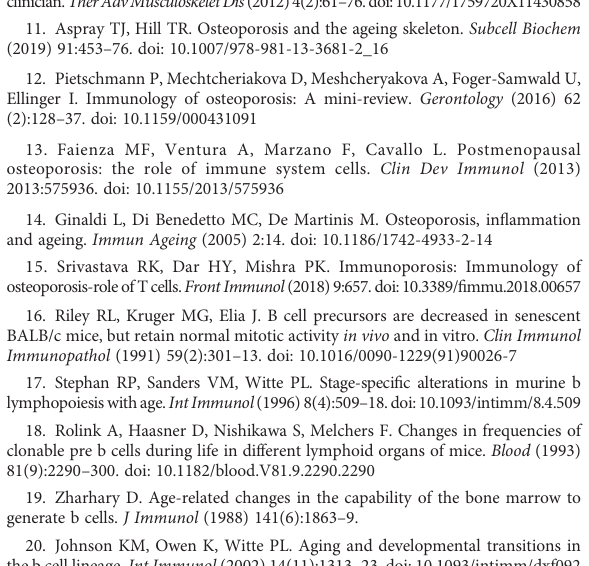
SUPPLEMENTARY FIGURE 2 Mousegenotypingandcon fi rmationoftheabsenceofpreBCRexpression in l 5 -/- mice. (A) Genotyping. The l 5 gene ( Igll1 ) was ampli fi ed by speci fi c primers. The presence of Igll1 was con fi rmed in WT and J H-/- mice (lane1 and 2, red box) while its absence was con fi rmed in l 5 -/- and J H-/- l 5 -/- mice (lanes 3 and 4). (B) Flow Cytometry. Flow cytometry was used to con fi rm the absence of preBCR expression in the mutant l 5- de fi cient strains. Early B cell subsets including preB cells were identi fi ed based on expression of surface markers including: CD19, B220, AA4.1, and BP-1. Cells were fi xed and permeabilized for intracellular staining. Antibodies speci fi c for the preBCR (SL156 clone) and Mu HC were used to con fi rm the presence of the preBCR-expressing cells in WT mice (31.1% of cells) and their absence bothon the cell surface and intracellularly in l 5 -/- mice. SUPPLEMENTARY FIGURE 3 Comparable numbers of osteoblasts and osteoclasts in bone marrow of recipientmice. (A) Undecalci fi edfemursfromadoptivetransfermicewere embedded in plastic, sectioned and stained with Masson ’ s trichrome. Representative images from the endosteal surface are shown at 10X magni fi cation. The yellow boxed region is shown at 40X magni fi cation. (B) Average histomorphometric values pooled from the indicated recipient mice (n=3-5 mice per group). No.Ob/BS=Number of osteoblasts per bone surface, ObS/BS=Osteoblast surface per bone surface, No.Oc/BS=number of osteoclasts per bone surface and OcS/ Bs=Osteoclast surface per bone surface. Statistical signi fi cance was calculated by AOVA. Scale bar: 100µm. Data were obtained from n=3-5 mice per